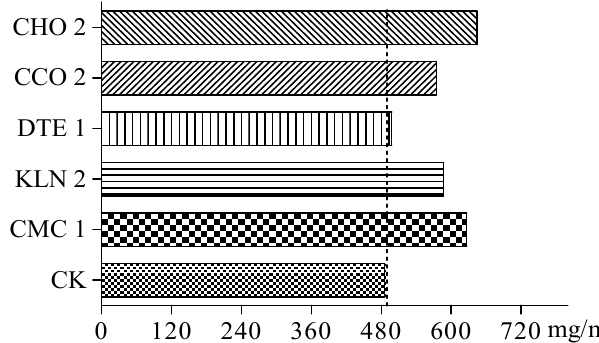
Figure 3. Particulate matter content from the chimney tail exhaust: calcium carbonate (CCO), calcium dihydrogen phosphate (CHO), carboxymethyl cellulose (CMC), control (CK), diatomaceous earth (DTE) and kaolin (KLN).